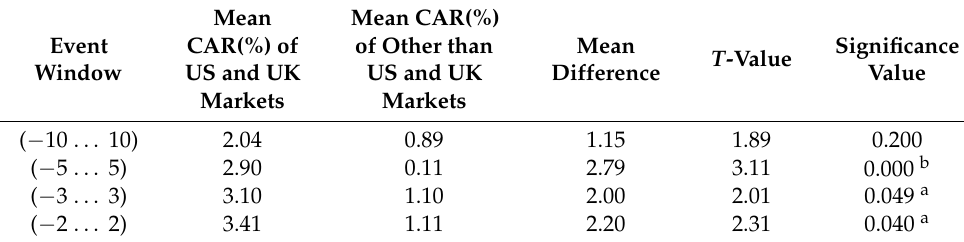
Table 7. T -test for difference of